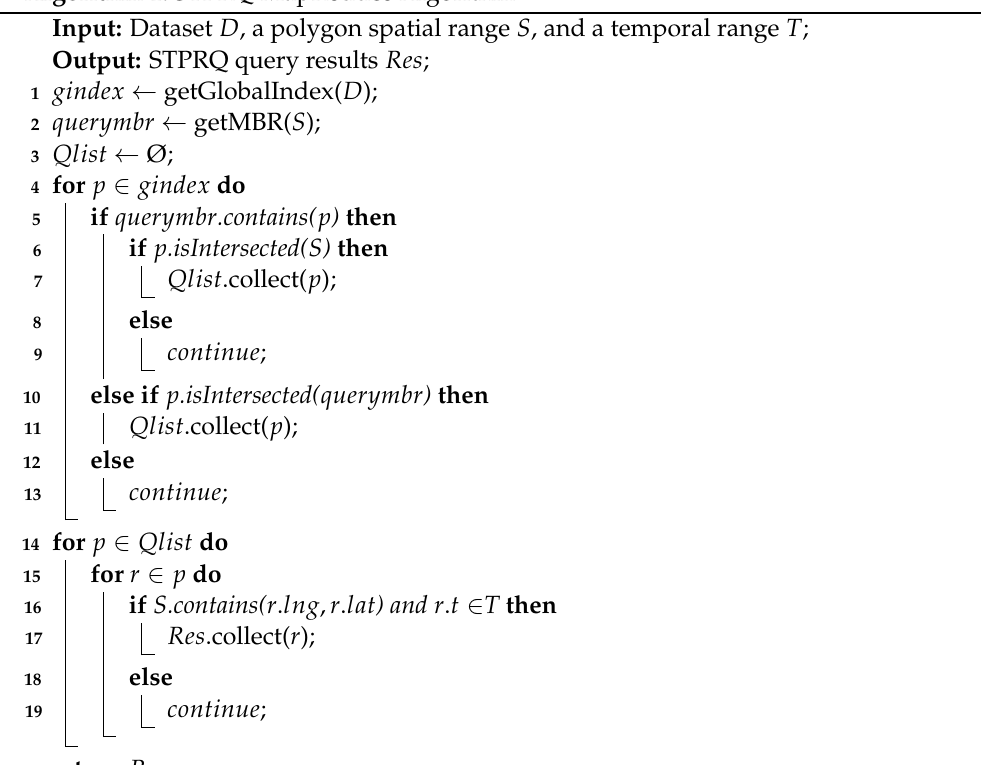
Algorithm 1: STPRQ MapReduce